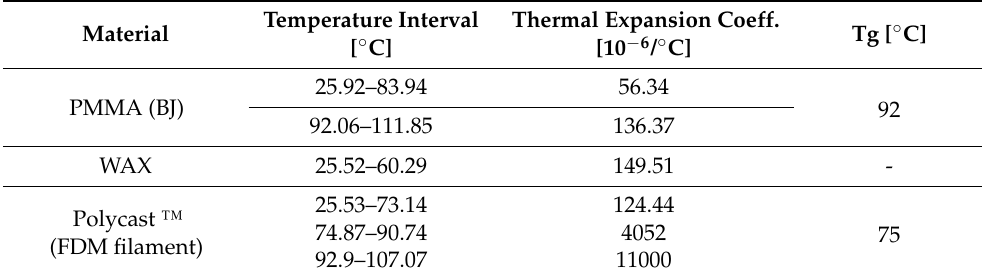
Table 2. Comparison of thermal expansion for selected